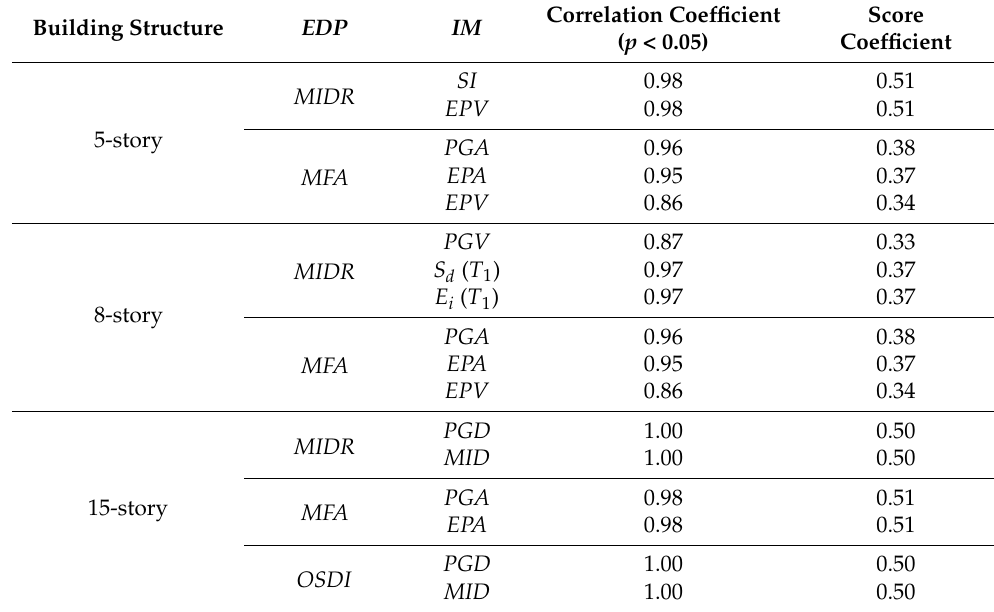
Table 10. Correlation coefficients and score coefficients between principal component f 1 and corre- sponding